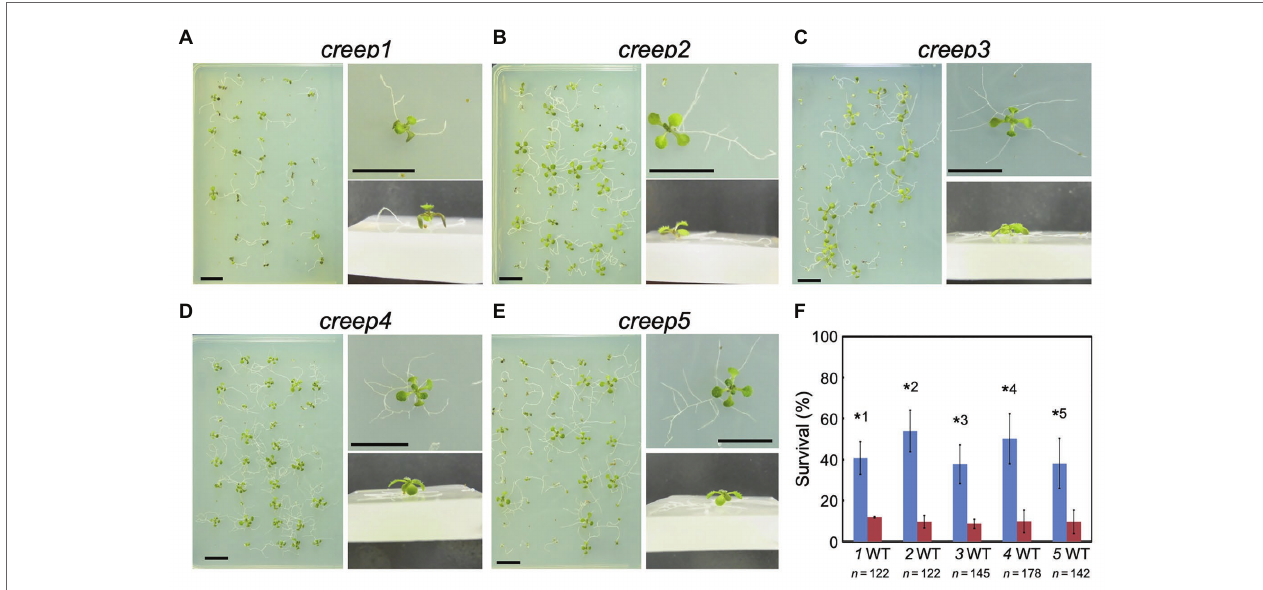
FIGURE 3 | Phenotypes of creep mutants on horizontal impenetrable medium. The growth conditions used were the same as those described in the legend to Figure 1 . Photographs were taken 15 days after sowing. (A–E) creep1 to creep 5 mutants. A set of three photographs (above view, close-up view from above, and oblique close-up view) are shown for each mutant. (F) Quantitative summary of viabilities assessed in at least three independent experiments. “ n ” represents the total number of surviving plants examined in three or more experiments. The numbers below the bar graph, 1–5, represent creep1 to creep5 mutants, respectively. The significance of differences between each mutant and the wild type was examined by the Student’s t -test. *1, p = 0.0065; *2, p = 0.0042; *3, p = 0.0019; *4, p = 0.0132; *5, p = 0.0403. Significance was defined as p <